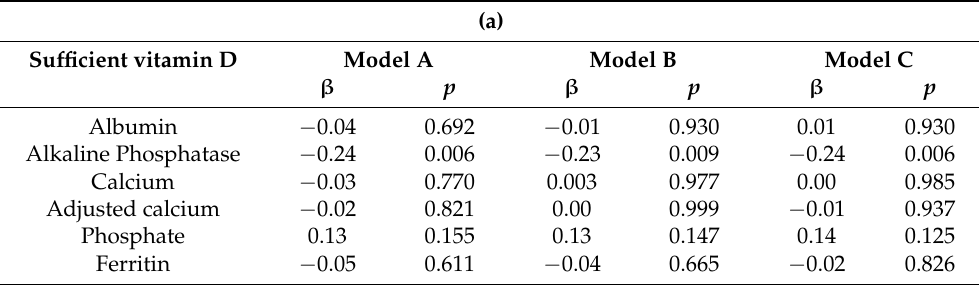
Table 2. ( a ) Association between caffeine intake and biochemical outcomes in pregnant women with sufficient vitamin D; ( b ) Association between caffeine intake and biomedical outcomes in pregnant women with insufficient vitamin